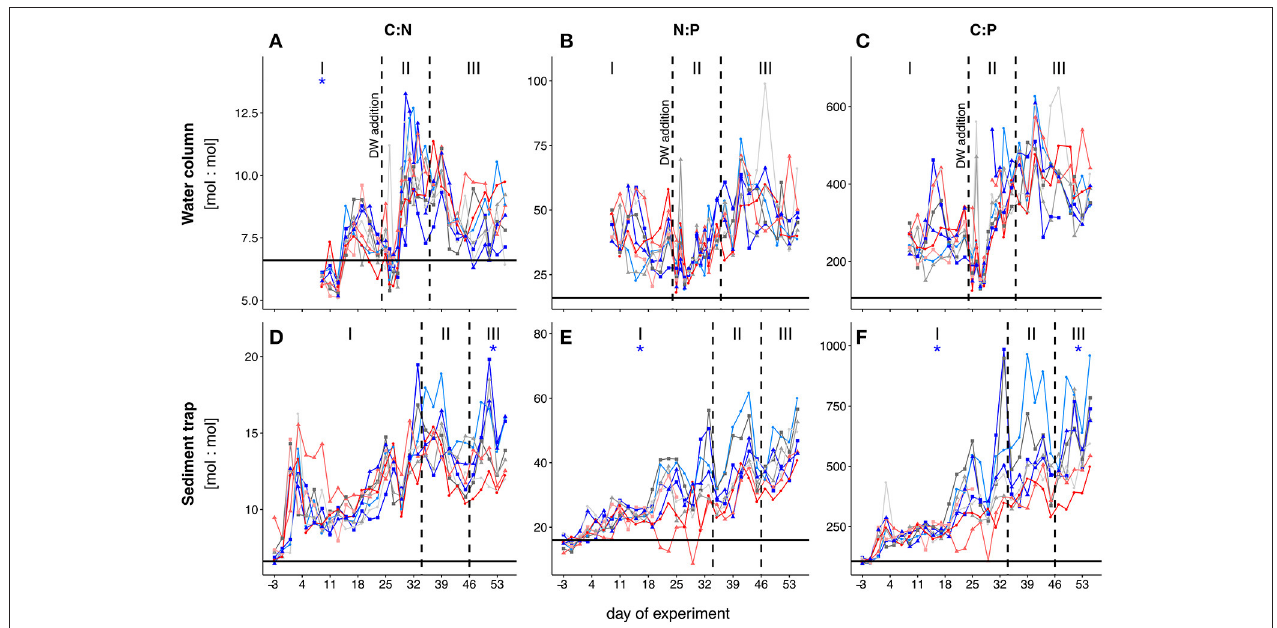
FIGURE 3 | Temporal development of POM elemental stoichiometries in the water column (A–C) and the sediment trap samples (D–F) . Black horizontal lines indicate Redfield proportions for the respective elemental ratios (C:N = 6.6, N:P = 16, C:P = 106). Colored lines depict the different mesocosms. The three different phases are indicated with I, II and III and separated by the dashed vertical lines. Note that the phases for water column and sediment trap POM have been defined differently (see section Chlorophyll a and Experimental Phases). Colors and symbols are described in Table 1 . The * denotes a statistically significant postitive (red) or negative (blue) effect of CO 2 during the respective experimental